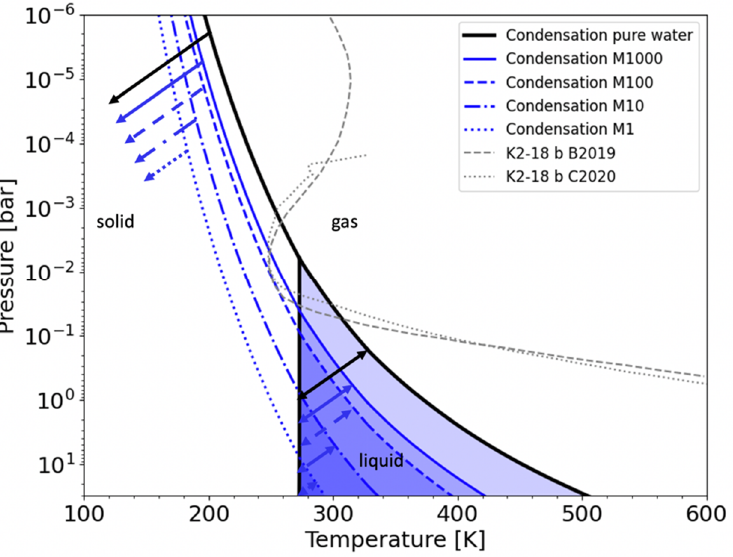
Figure 4. Water equilibrium phase diagram showing condensation curves for varying water content. The x axis shows temperature and the y axis shows pressure. The black solid line is the condensation for pure water and the blue lines show condensation for atmospheres of different water content (corresponding to the different panels in Figure 3). Metallicity values translate to approximate water vapor content in a 90% H 2 and 10% He atmosphere as follows: M1 (solar metallicity) ~ 0.00078; M10 (10 × solar) ~ 0.0077; M100 (100 × solar) ~ 0.068; M1000 (1000 × solar) ~ 0.16. The arrows in the top left show that to the left of each condensation curve water will be in solid form (ice). The blue-shaded regions indicate the temperatures and pressures where water is in the liquid phase for different water content; the double-headed arrows indicate the liquid water range for different values of atmospheric water content. The black vertical line is the liquid/solid phase boundary common to all values of atmospheric water content, because the freezing temperature for water (273 K) is insensitive to pressure for pressures less than approximately 100 bar. The grey dashed and dotted lines show two different K2-18b atmosphere profiles that fit Hubble data (from [12,49]), both are for atmospheric metallicities of 100× solar (B2019 is the Bond albedo = 0.3 case from [12] and C2020 is from [51]). Because the grey curves intersect the condensation curve for an atmosphere with metallicity of 100 (blue dashed curve) but do not pass through the liquid water region for an atmosphere metallicity of 100, the models show that water will be in ice and not liquid form. To support liquid water clouds, planet atmosphere temperature–pressure profiles must pass through the liquid water region of the phase diagram.